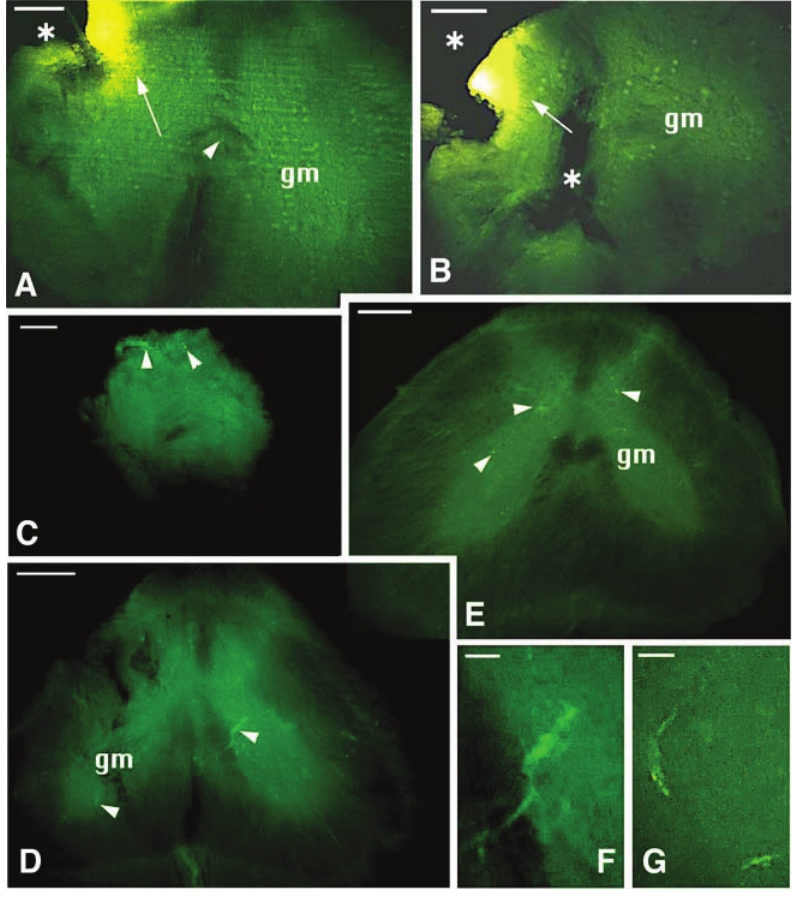
Figure 8. Proximal-distal representative cross-sections of the SC in case 2 (completely transected with poor recovery) after Dil application. A , caudalmost area located near the point of application of the tracer (the arrow points to the region that has incorporated most of the tracer). The asterisk indicates that some tissue is missing due to the sectioning. The arrowhead points to the central canal. gm, grey matter. Scale bar, 0.1 mm. B , more rostral section of the SC near the bridge region (the arrow indicates the most labeled area). Asterisks point to regions with missing tissue due to the sectioning. gm, grey matter. Scale bar, 0.1 mm. C , narrow spinal cord in the bridge area. The arrowheads indicate few axons containing higher levels of the tracer. Scale bar, 0.1 mm. D , cross section of the rostral spinal cord stump past the bridge region showing some labeled neurons (arrowheads) in the grey matter (gm). Scale bar, 0.15 mm. E , a rostral most section showing most labeled neurons (arrowheads) in the medial-upper part of the grey matter (gm). Scale bar, 0.15 mm. F , detail on a labeled neuron in the medial ventral grey matter. Scale bar, 10 (cid:2) m. G , detail of labeled neurons localized in intermediate grey matter area. Scale bar, 10 (cid:2)